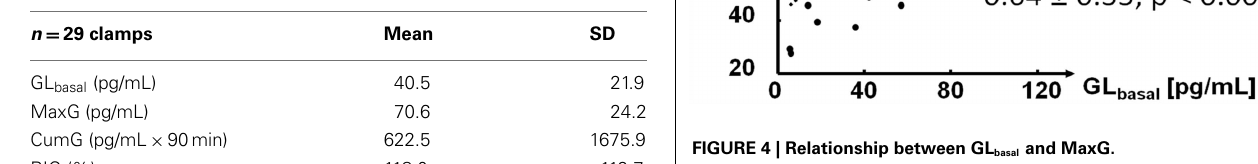
Table 1 | Measures of basal glucagon and GCR in the study.